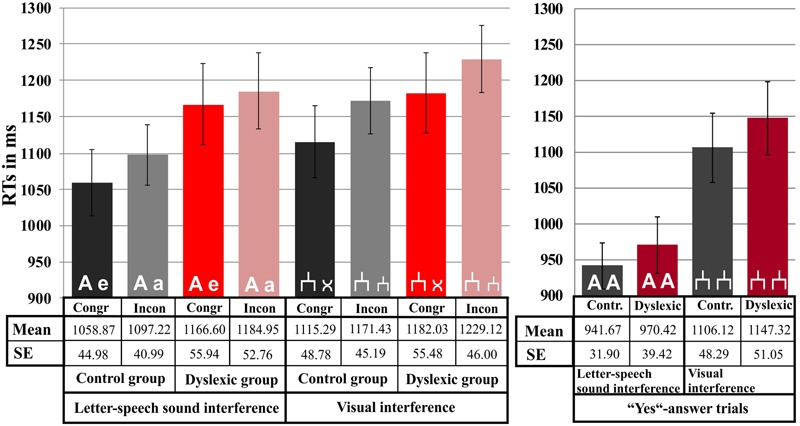
Response time results. Mean values are depicted separately for each experiment, condition and group. Error bars represent the standard error of mean.